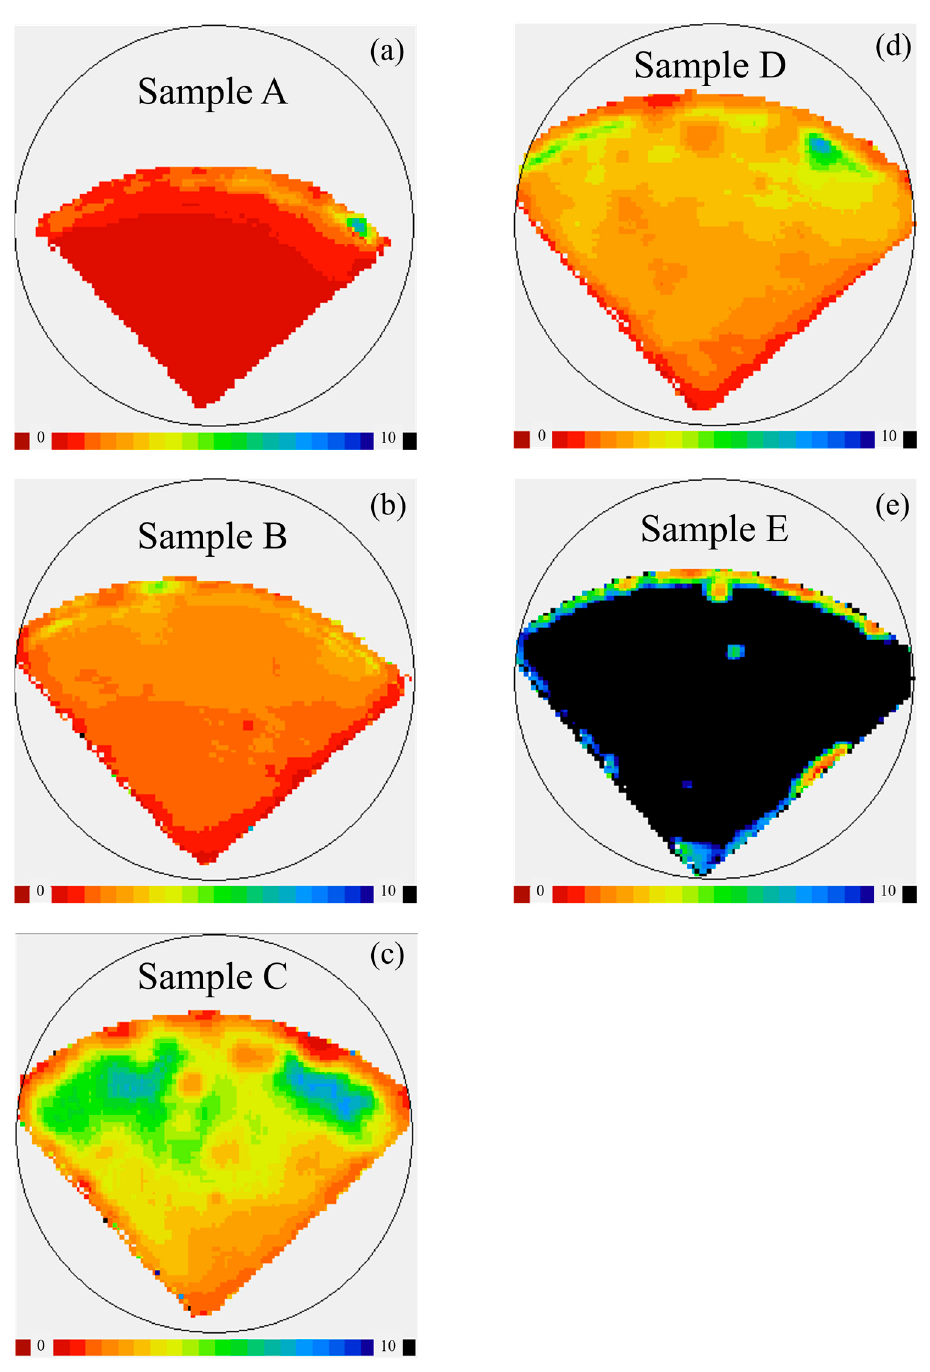
Figure 6. Minority carrier lifetime mappings for samples A, B, C, D, and E. ( a – e ) are samples A, B, C, D, and E,